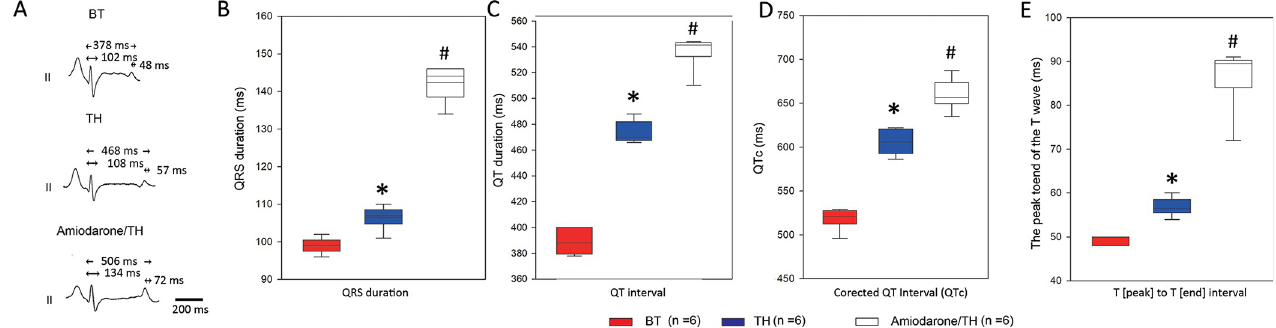
Fig 1. Sequential changes in the surface ECG parameters after TH and amiodarone treatment. (A) Representative ECG parameters (QRS duration, QT interval, and TpTe interval) at BT (upper panel), TH (middle panel), and amiodarone/TH (lower panel) of pig 3 during SR. The ECG parameters analyzed included the following: (B) QRS durations, (C) QT intervals, (D) QTc intervals, and (E) TpTe intervals. TH increased all ECG parameters compared with BT. However, even under TH, amiodarone treatment further increased the durations of all ECG parameters. These data were derived from all the six pigs from this study. * P < 0.05, BT vs. TH; # P < 0.05, TH vs. Amiodarone/TH, both by the paired t-test. The data were presented as means ± standard deviations. BT, baseline temperature; ECG, electrocardiography; QTc, corrected QT; TH, therapeutic hypothermia; TpTe, T-peak to T-end interval. https://doi.org/10.1371/journal.pone.0282943.g001 1.8 ± 0.1, and 1.76 ± 0.1 m/s, respectively). During RVP, a similar decrease in the CV was observed ( Table 1 and Fig 3 A; 2.0 ± 0.1 vs. 1.8 ± 0.05 vs. 1.7 ± 0.1 m/s, respectively).